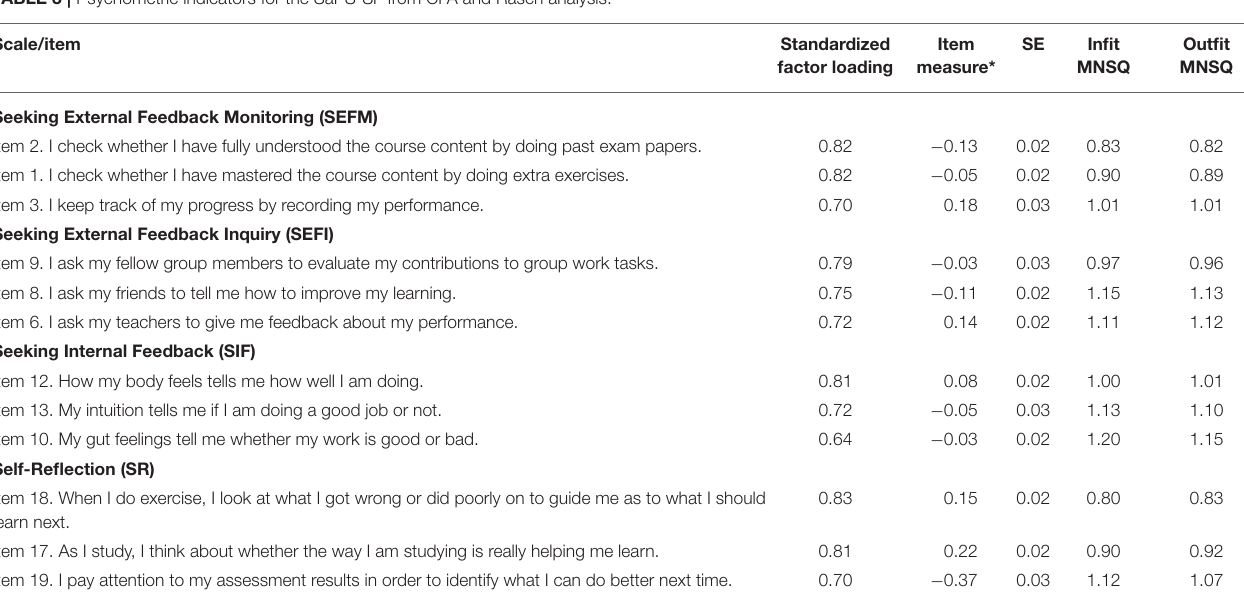
TABLE 3 | Psychometric indicators for the SaPS-SF from CFA and Rasch analysis.